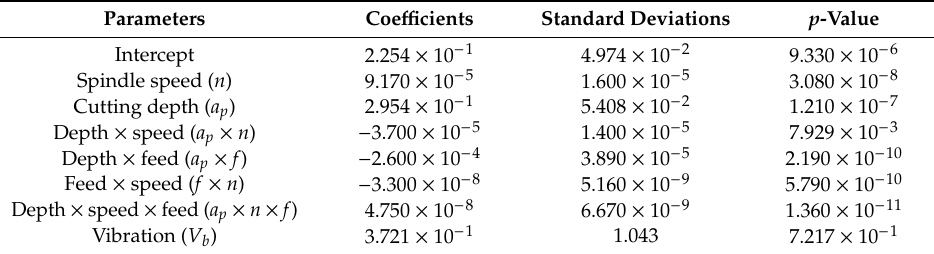
Table 4. Regression parameters of the nonlinear polynomial